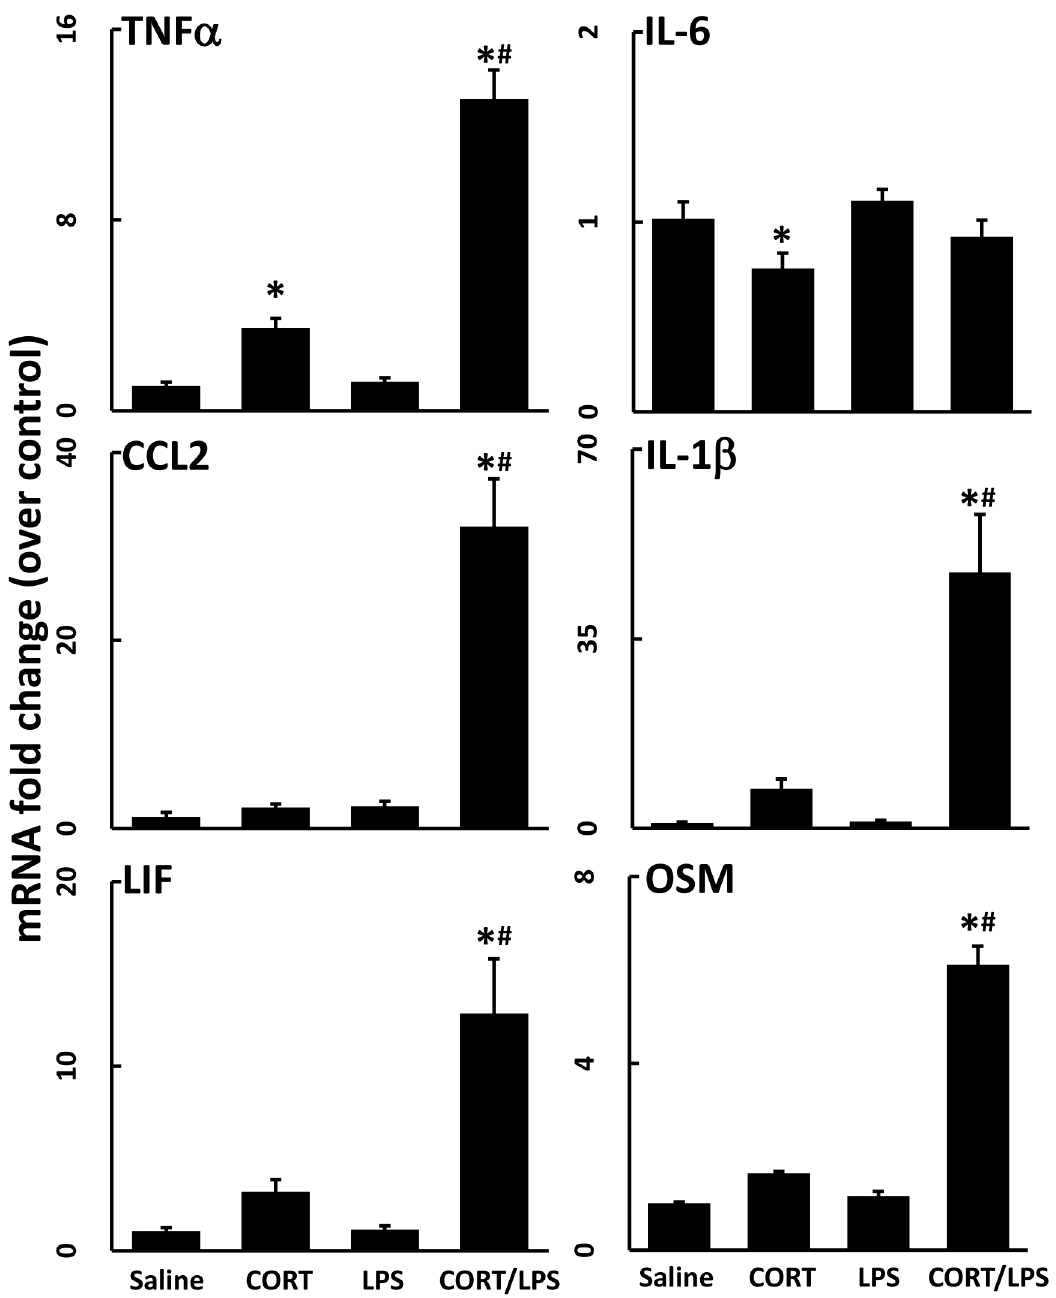
Fig 4. Chronic CORT sensitizes the CNS to a sub-neuroinflammatory inhalation dose of LPS. Mice pretreated with CORT (200 mg/L 0.6% EtOH in drinking water for one week) were subjected to 3 hours of LPS (7.5 μg/m 3 ) by inhalation. TNF α , IL-6, CCL2, IL- 1 β , LIF, and OSM mRNA levels were measured in samples prepared from cortex collected immediately following LPS inhalation exposure. Data represent mean ± SEM (n = 5 mice/group). Statistical significance of at least P < 0.05 is denoted by (cid:3) as compared to respective control and # as compared to LPS alone exposed